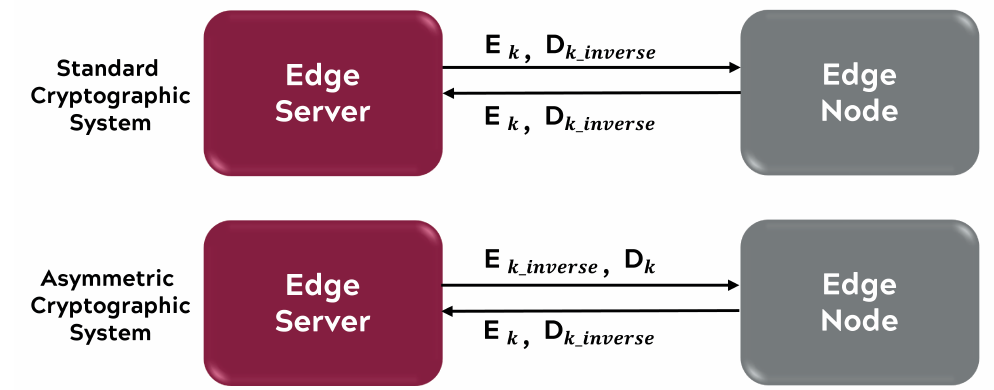
Figure 3. Comparison between asymmetric and standard